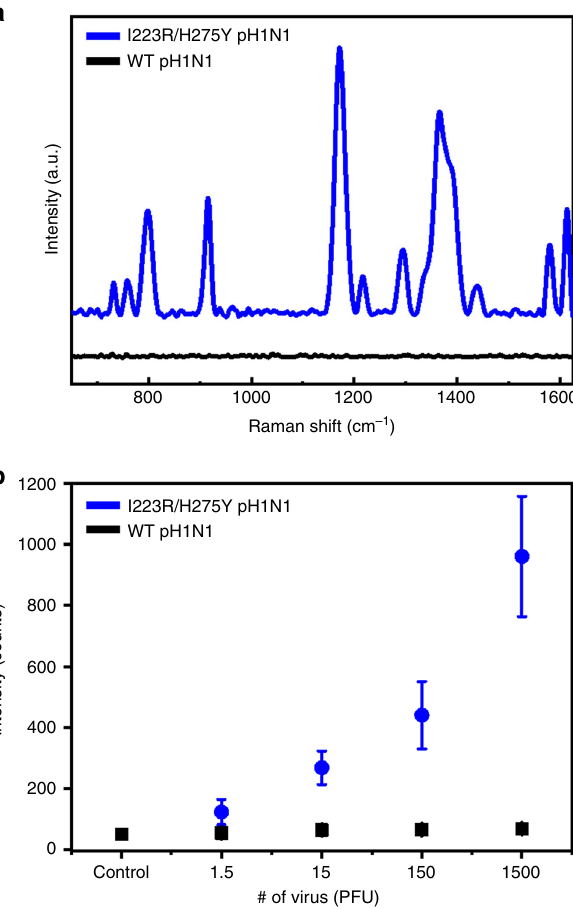
Fig. 6 SERS-based detection of I223R/H275Y pH1N1 using A4. a SERS spectra of MGITC obtained from NPs-on-plate structures in the presence of I223R/H275Y pH1N1 and wt pH1N1. The number of both viruses is 1500 PFU. Each experiment was repeated ten times independently with similar results. b Plot of 1175 cm − 1 band intensity versus the number of in fl uenza virus. Data represent the average plus/minus standard deviation from ten